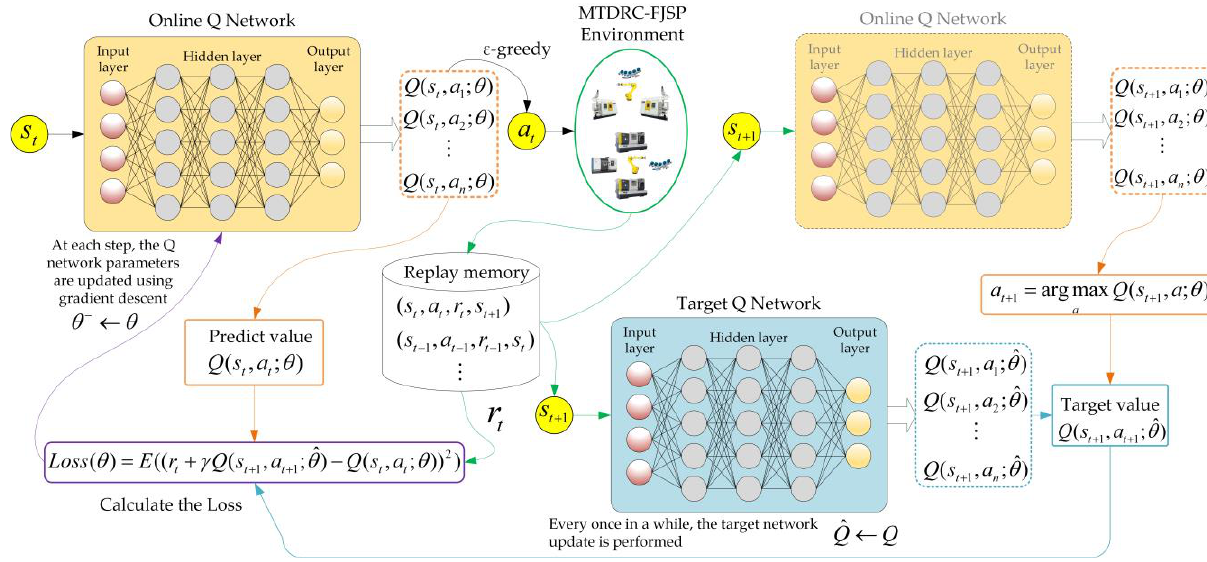
Figure 4. Principle of DDQN for solving scheduling.